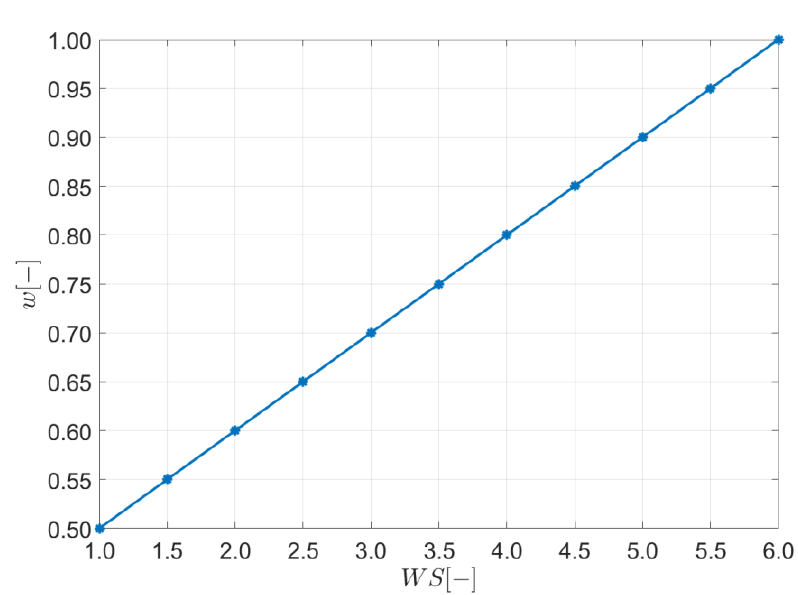
Figure 4. Criterion weight as a function of weight superiority parameter.